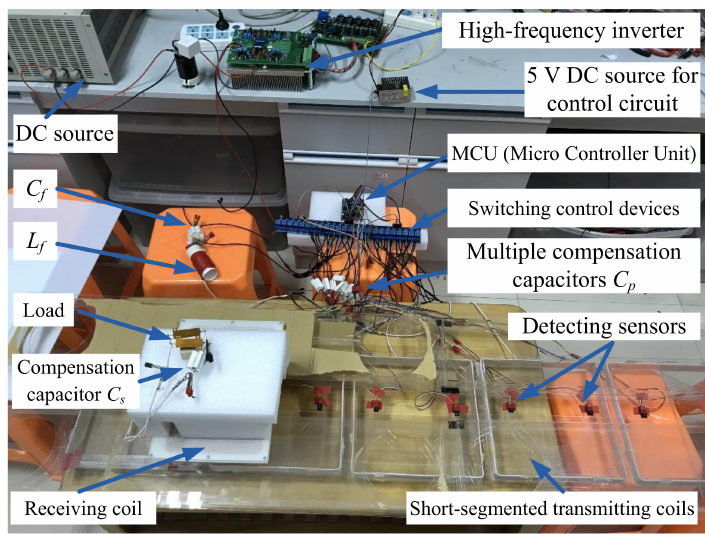
Figure 11. The prototype of the static-dynamic hybrid wireless charging system with multiple transmitting coils.